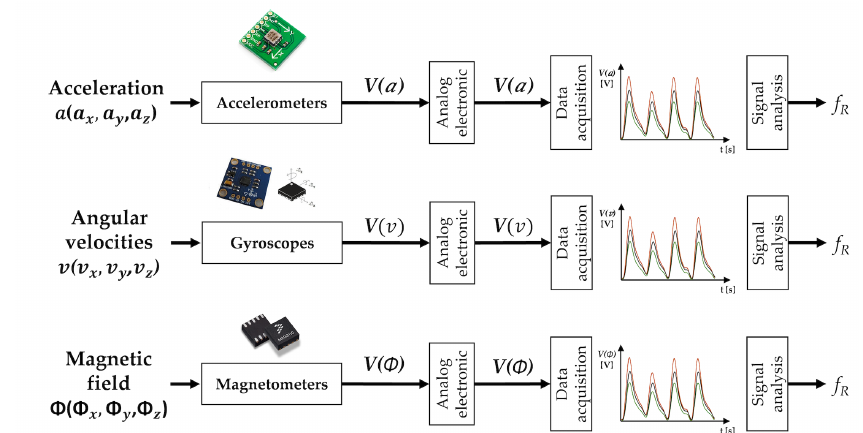
Figure 9. Movement sensors: the main elements composing the measuring chain (sensor, analog electronics, data acquisition, post-processing or signal analysis stage) to estimate f R . The output quantities are different among sensors. ( a x , a y , a z ) , ( v x , v y , v z ) , and ( Φ x , Φ y , Φ z ) are three-axis accelerations, three-axis angular velocities, and three-axis magnetic field outputs changes caused by the acceleration ( a ), angular velocity ( v ) and magnetic field ( Φ ) changes, respectively. V ( . ) is the voltage